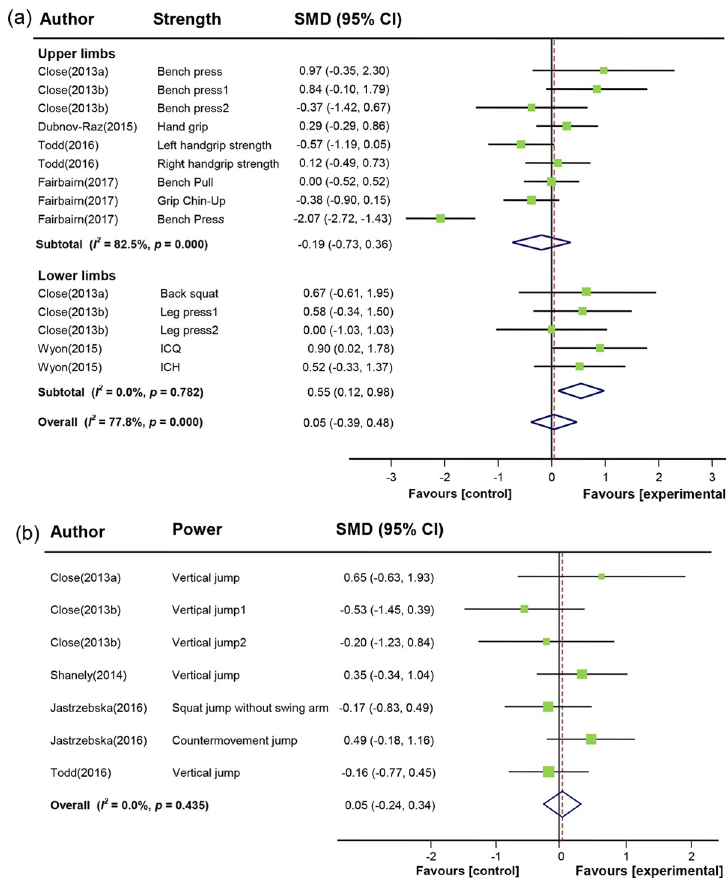
Fig 2. Forest plot displaying the effect of vitamin D supplementation on muscle strength and power. (a) Effect of vitamin D supplementation on upper and lower limb muscle strength. (b) Effect of vitamin D supplementation on muscle power. SMD: standardized mean differences. 95% CI: 95% confidence interval. I 2 : I-squared test of heterogeneity. Bench press1 / Leg press 1: oral vitamin D 3 20000 IU/week for 12 weeks. Bench press 2/ Leg press 2: oral vitamin D 3 40000 IU/week for 12 weeks. ICQ: isokinetic concentric quadriceps peak torque. ICH: isokinetic concentric hamstring peak torque. Vertical jump1: oral vitamin D 3 20000 IU/week for 12 weeks. Vertical jump2: oral vitamin D 3 40000 IU/week for 12 weeks.